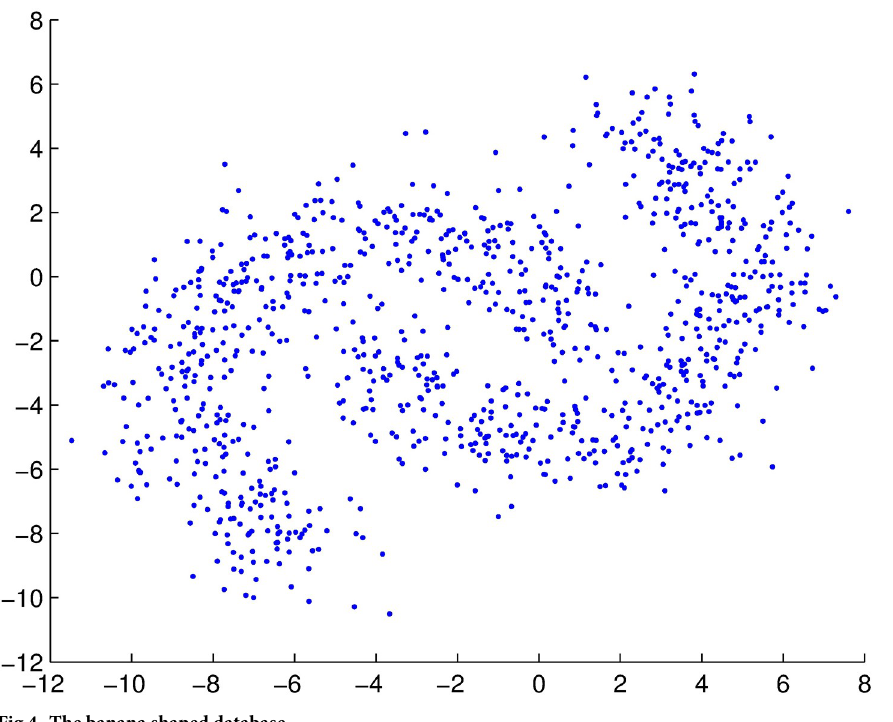
Fig 4. The banana shaped